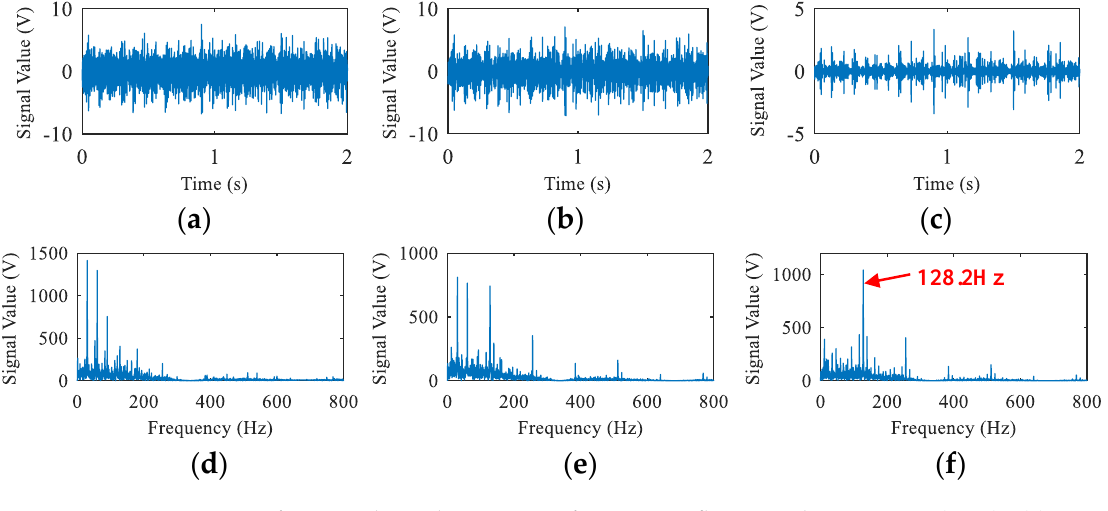
Figure 12. Time waveforms and envelop spectra of outer race flaw signal at 1800rpm (CH3). ( a ) Waveform of the raw data. ( b ) Waveform of the signal after high-pass filter with cutoff-frequency 1KHz. ( c ) Waveform of the signal after high-pass filter with the optimized cutoff frequency. ( d ) Envelop spectrum of the raw data. ( e ) Envelop spectrum of the signal after high-pass filter with cutoff-frequency 1KHz. ( f ) Envelop spectrum of the signal after high-pass filter with the optimized cutoff frequency.